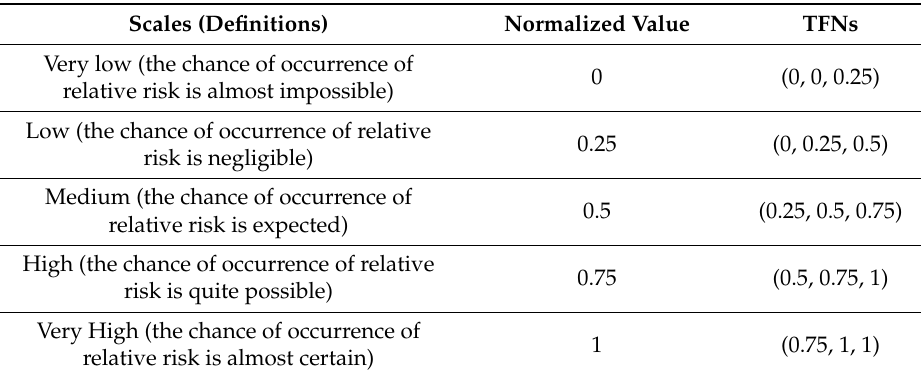
Table 2. Linguistic variables for